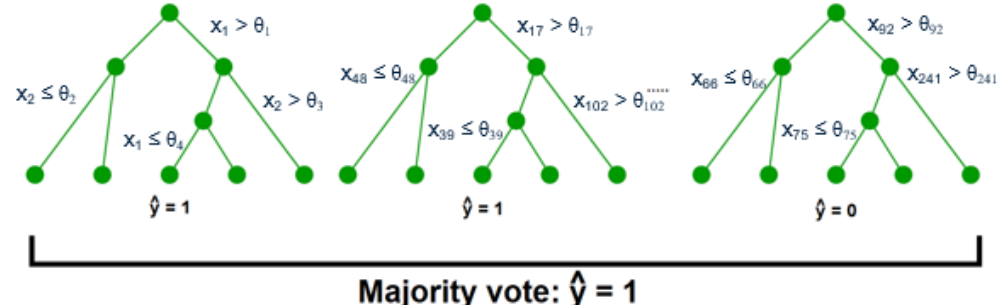
Figure A1. Multiple random forests constructed for a binary-class problem. The outcomes (either Class 0 or 1) are decided by combining sequential splits of d k randomly selected features, from the original d x -dimensional feature space. The final outcome is determined by a majority vote of individual outcomes from all